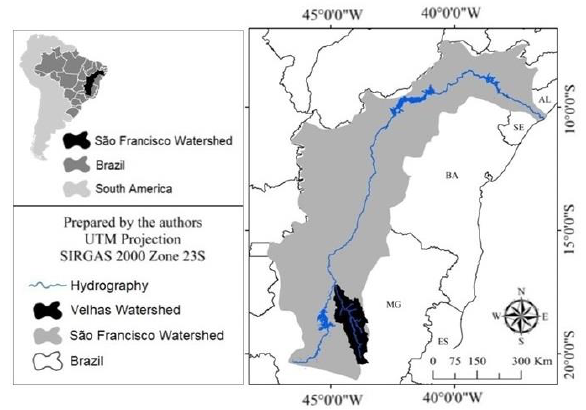
Figure 1. Location of the Velhas River Watershed